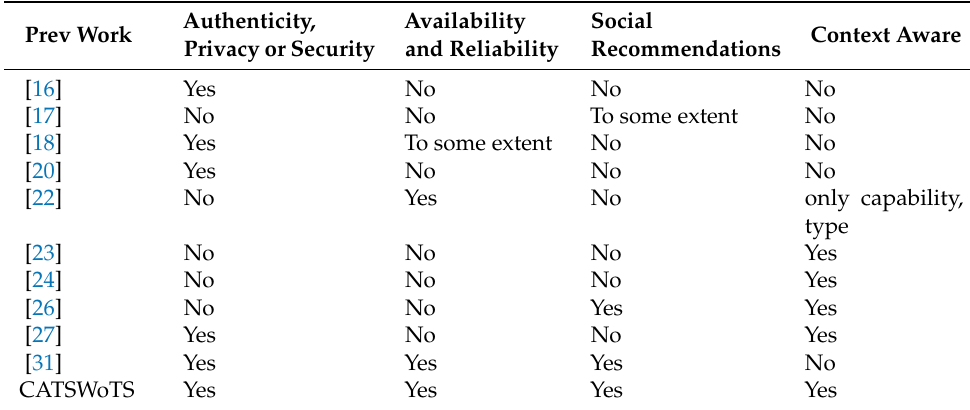
Table 2. Comparison with related